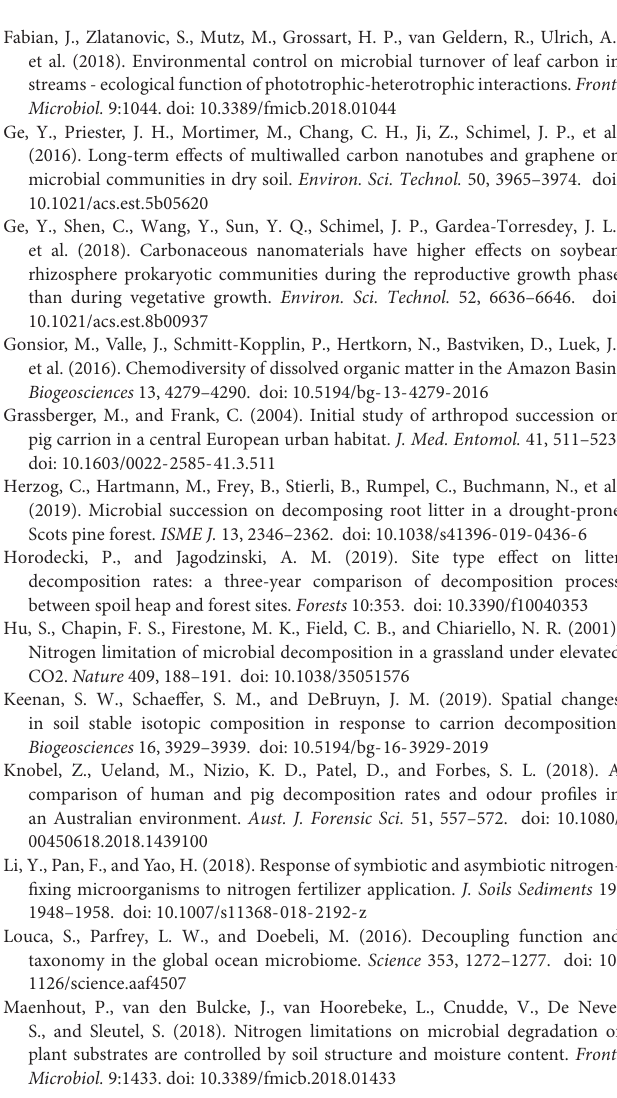
Supplementary Figure 2 | The fluorescence intensity of earthworm dissolved organic matter (DOM) at different sampling times. Supplementary Figure 3 | The unique and shared OTUs between likely source environments. Supplementary Figure 4 | Correlations between bacterial community and mass loss of decaying earthworm in both soils, native soil treatment, and non-native soil treatment. Supplementary Figure 5 | The specific bacterial functional groups associated with decomposition phase in native and non-native soils. Supplementary Table 1 | The physico-chemical properties of native soil and non-native soil. Supplementary Table 2 | Significance test of mass loss between native soil and non-native soil at specific sampling times. Supplementary Table 3 | The proportion of different dissolved organic matter (DOM) types at specific sampling times in native soil treatment and non-native soil treatment.